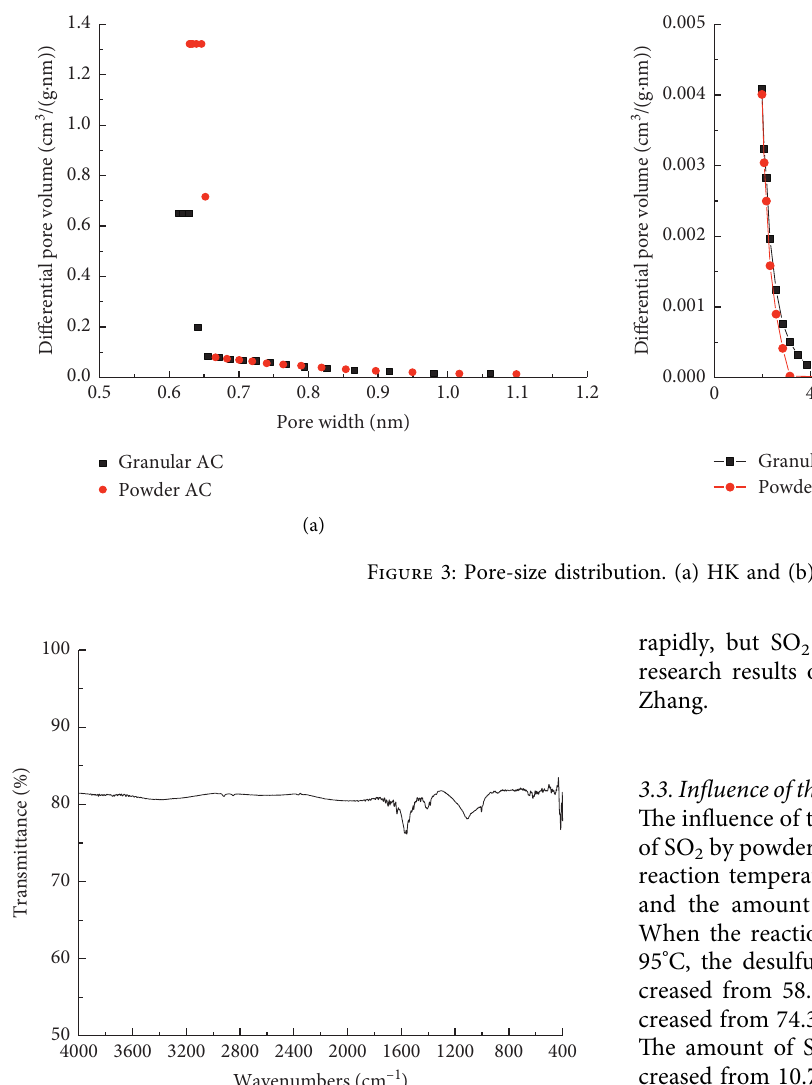
Figure 4: FT-IR spectra of the powdered